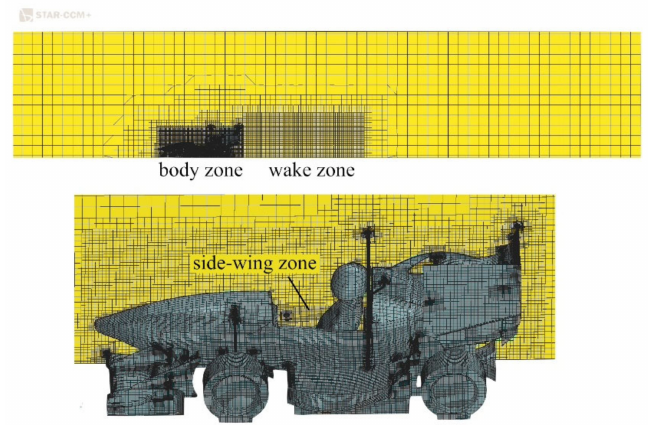
Figure 10. Mesh operation results and three different zones (body, wake, side wing) that are densified.